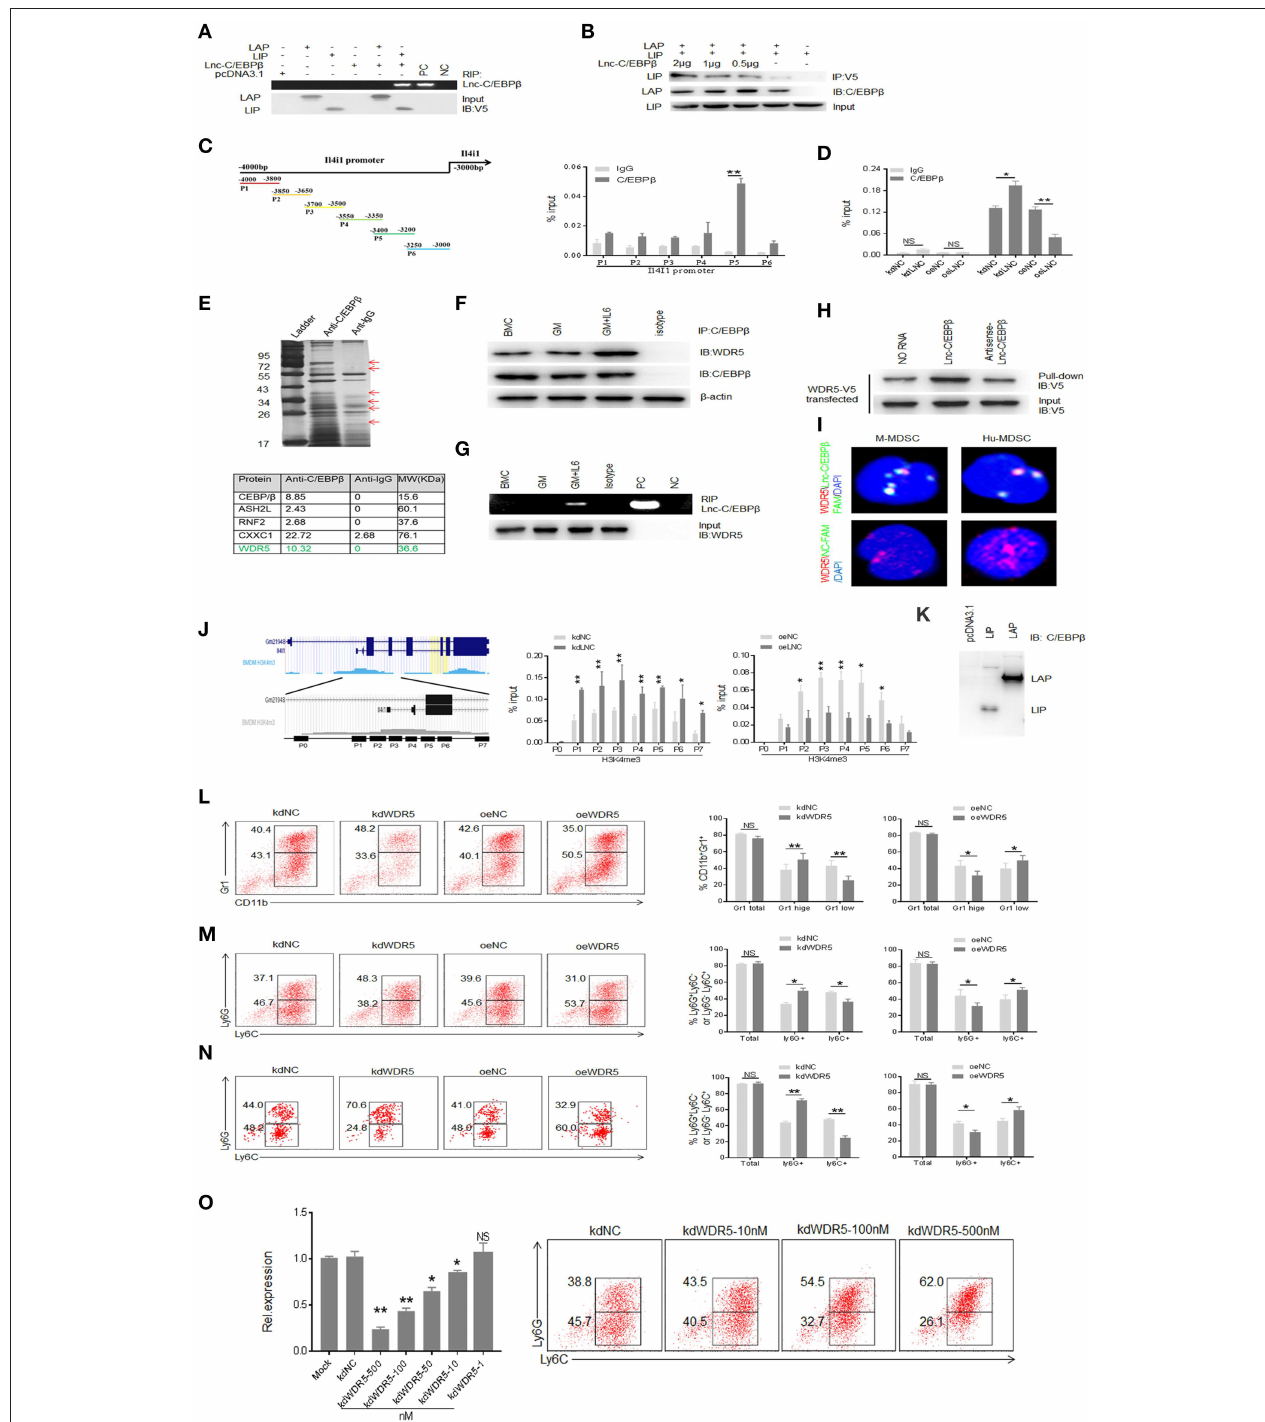
FIGURE 5 | Binding of lnc-C/EBP β with C/EBP β isoform LIP and WDR5 is required for Lnc-C/EBP β mediated Differentiation of MDSC. (A) RIP in V5-tagged LAP or LIP and lnc-C/EBP β cotransfected HEK293T cells. RIP was performed using anti-V5 antibody and then PCR for lnc-C/EBP β . pcDNA3.1, control plasmid; PC, positive control; NC, water. (B) Immunoblot of LAP and LIP in HEK293T cells. LIP/pcDNA3.1 (without V5-tagged), V5-tagged LAP/pcDNA3.1, and different concentrations of lnc-C/EBP β pcDNA3.1 plasmids were cotransfected into 293T cells. IP was performed using V5 antibodies, and then immunoblot using anti-C/EBP β (specific for both LAP and LIP). (C,D) CHIP-PCR on the promoter of IL4il of MDSCs. (E) IP-MASS of C/EBP β interacting proteins (upper); Five C/EBP β interacting partners associated